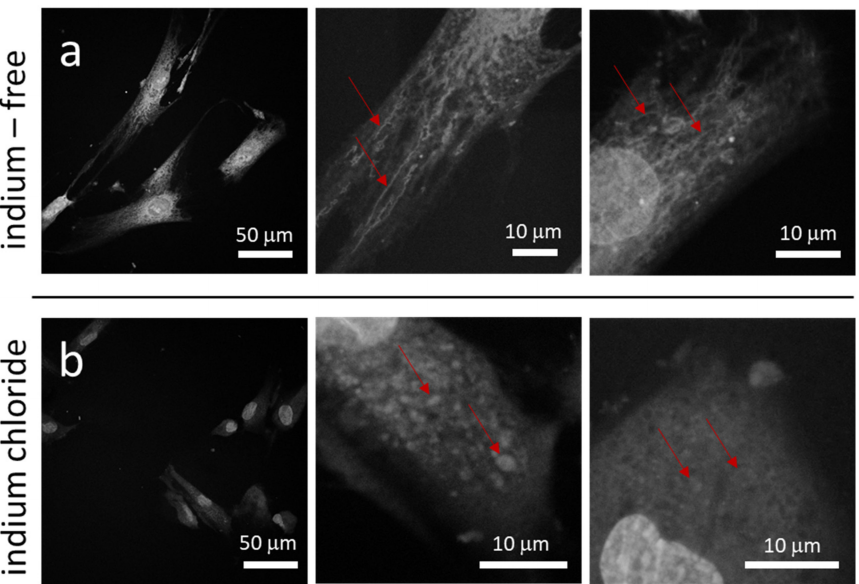
Figure 3. Fluorescence confocal micrographs of mitochondria within adherent cells in culture dish prepared in ( a ) medium without InCl 3 and ( b ) medium containing 3.2 mM of InCl 3 . Images show long tubular mitochondria form networks in cells incubated in indium-free media. When treated with indium chloride, mitochondria are punctate in shape. The red arrows highlight stained